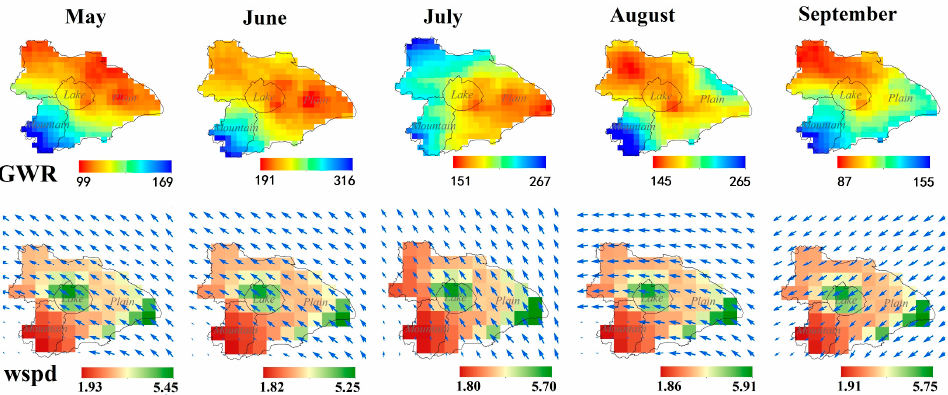
Figure 12. Spatial distribution of monthly precipitation and wind speed in flood season in the Taihu Lake Basin.